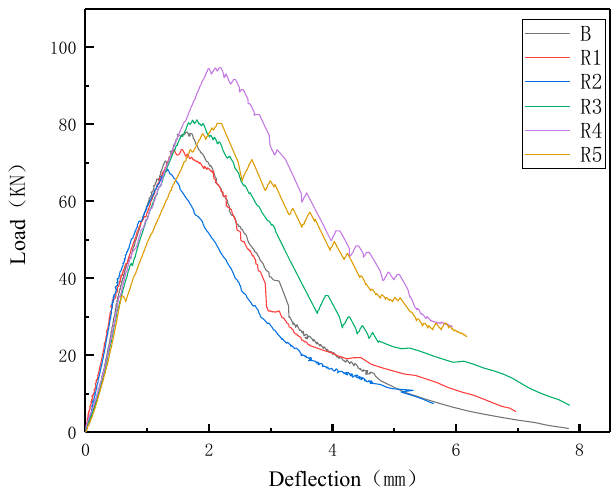
Figure 6. Load–deflection curve of recycled brick powder UHPC. Table 7. Calculation results of bending toughness index.